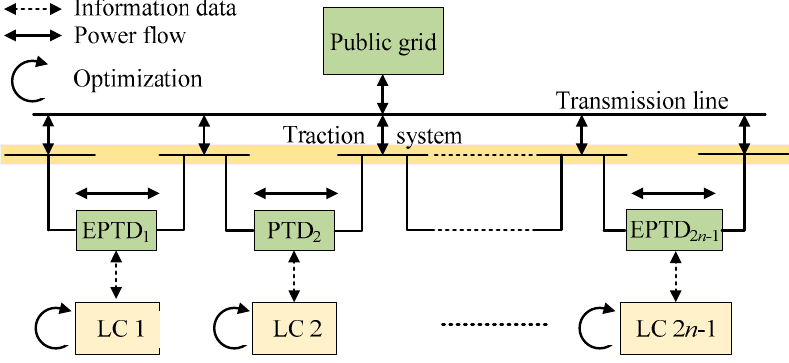
Figure 5. Structure of the decentralized control for the modified system.